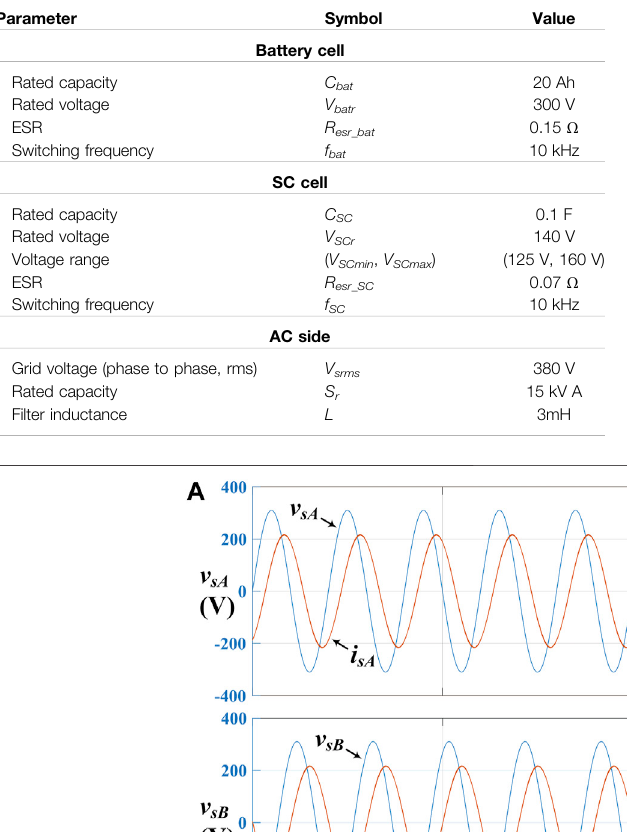
TABLE 1 | Simulation and experiment parameter.